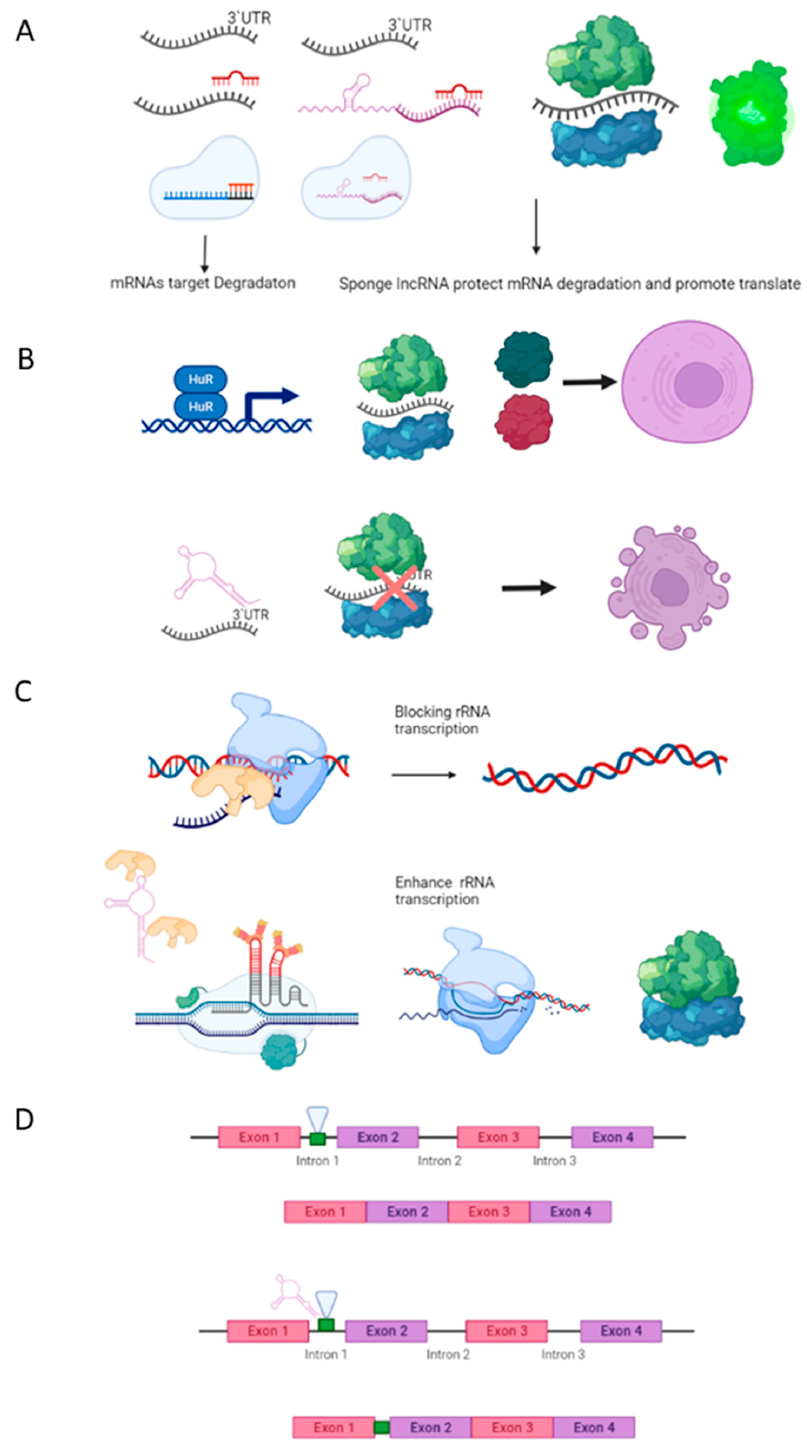
Figure 3. Main regulatory mechanisms of lncRNAs at the post-transcriptional level. ( A ) Competing sponge lncRNAs act to form an lncRNA-miRNA complex, avoiding the degradation of 3 ′ UTR target genes, therein repressing the translation of them. ( B ) lncRNAs binding mRNA targets and avoiding the ribosome-initiated translation process. In sharp contrast, the mRNA-lncRNA complex attenuates the binding of repressed protein translation. ( C ) lncRNAs can act as positive modulators of rRNA synthesis, increasing the ribosome pool necessary for the increased protein demand in cancer